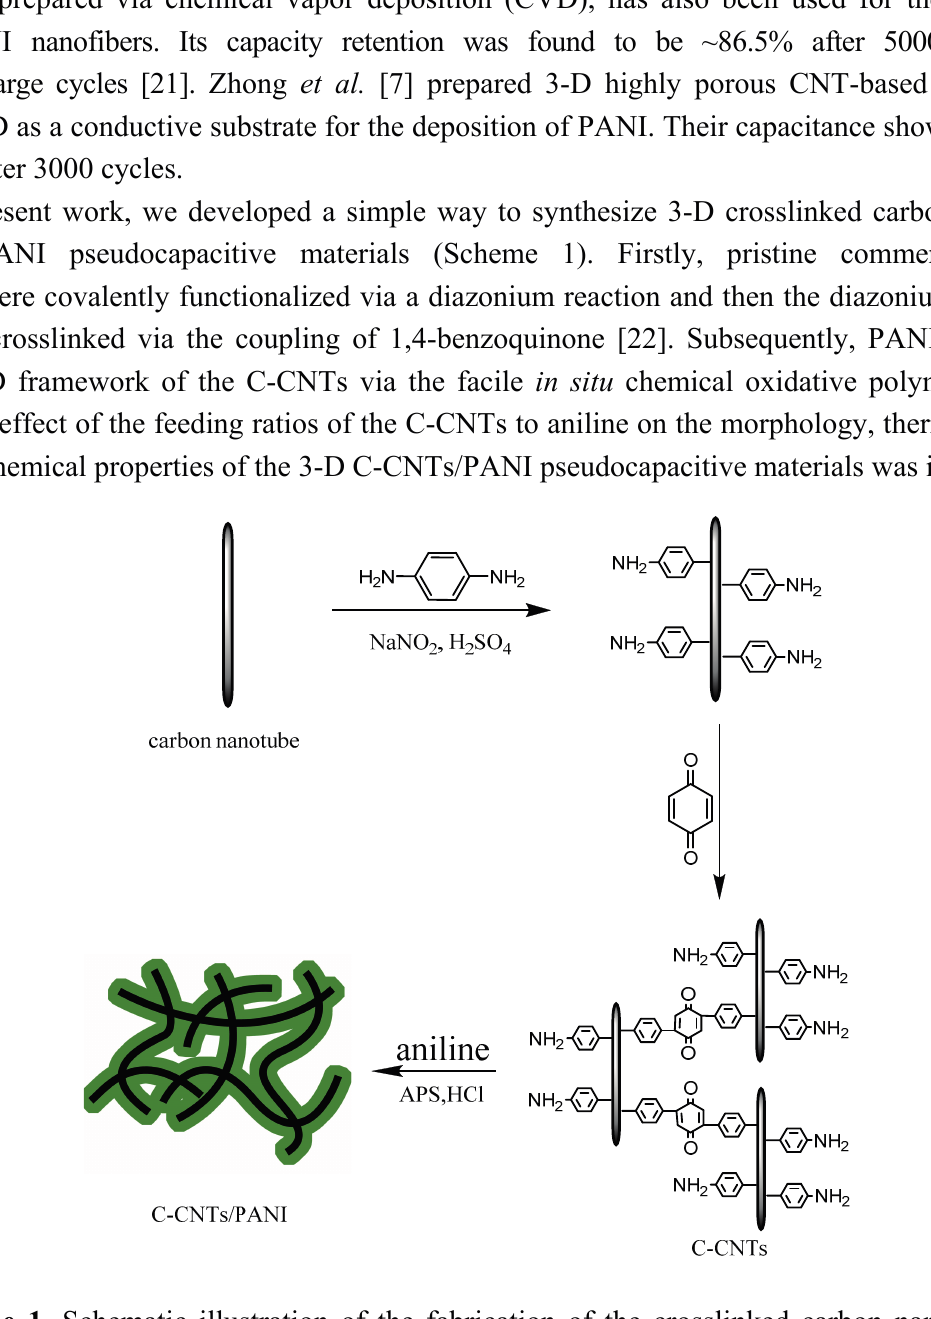
Scheme 1. Schematic illustration of the fabrication of the crosslinked carbon nanotubes (C-CNTs) and C-CNTs/polyaniline (PANI)